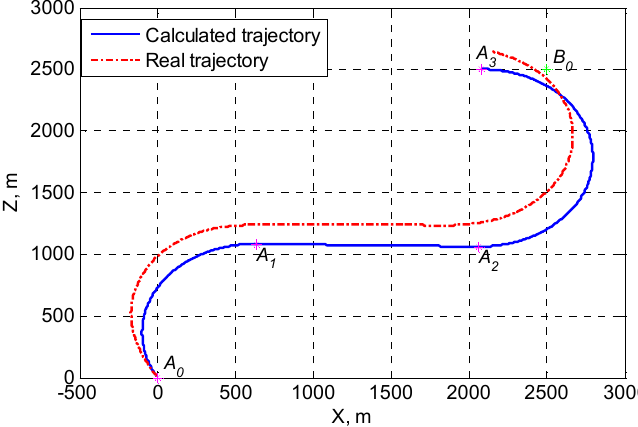
Figure 6. Projection of the space motion trajectory of the UAV in the horizontal plane 𝑋𝑍 .